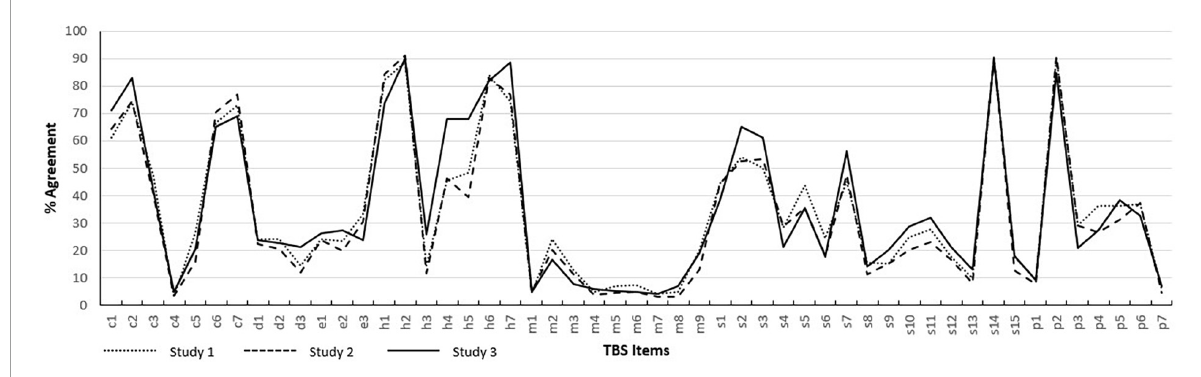
FIGURE1 Item-level endorsement for Study 1, Study 2, and Study 3. Item-level data is presented in Supplementary Appendix A .